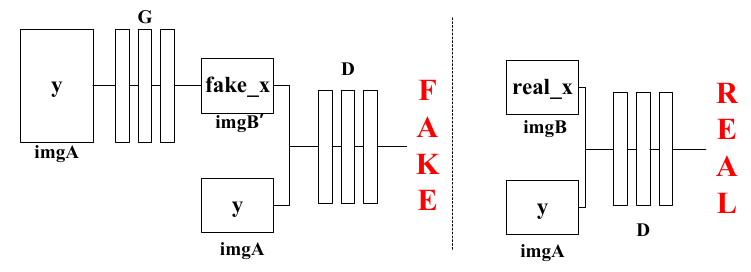
Figure 3. Pix2Pix training diagram.